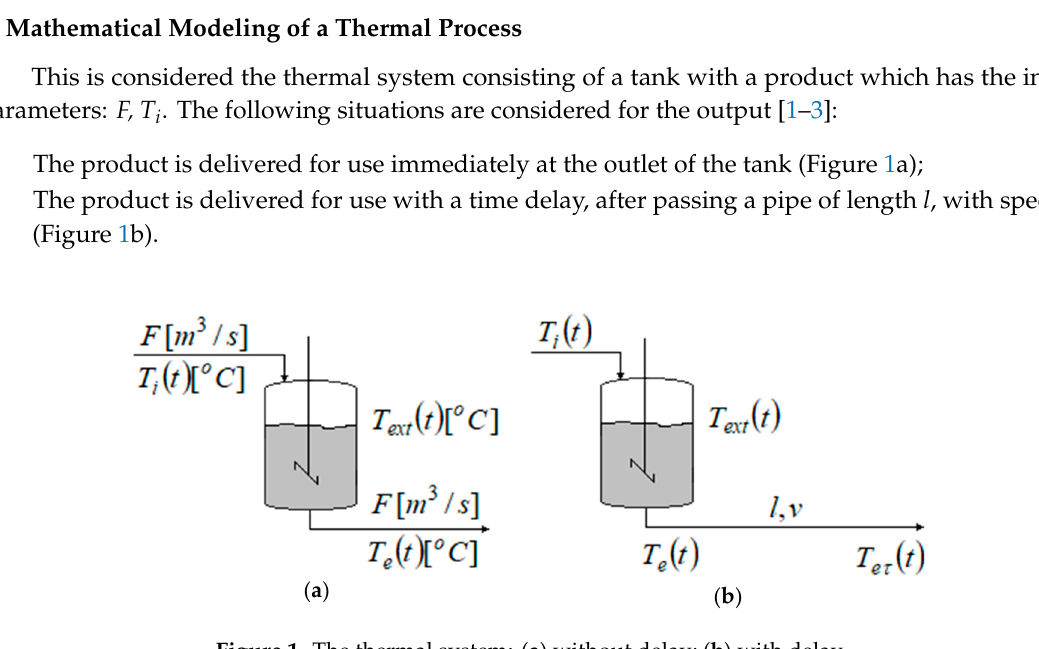
Figure 1. The thermal system: ( a ) without delay; ( b ) with delay.